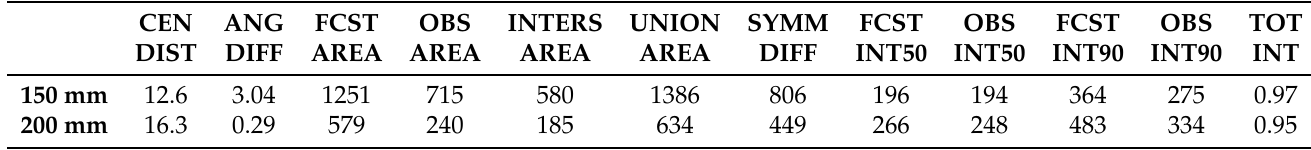
Table 3. WRF-DA forecast validation through the MODE tool.